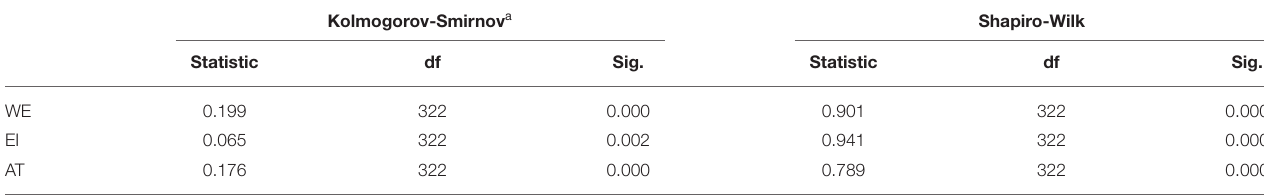
TABLE 2 | Test of normality.